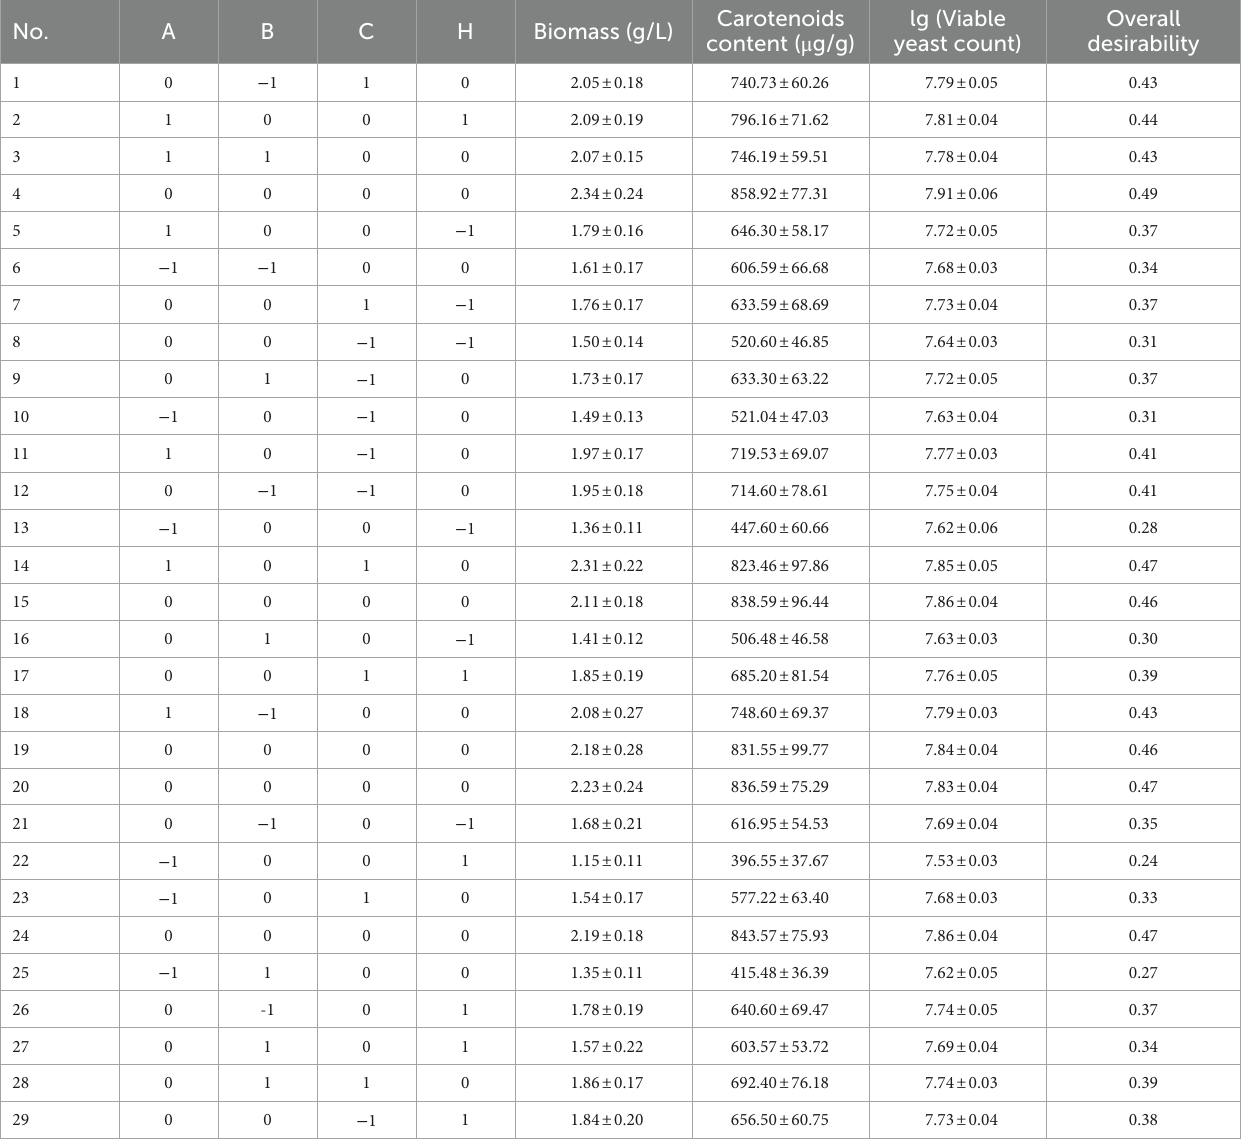
TABLE 5 Response surface methodology results of process